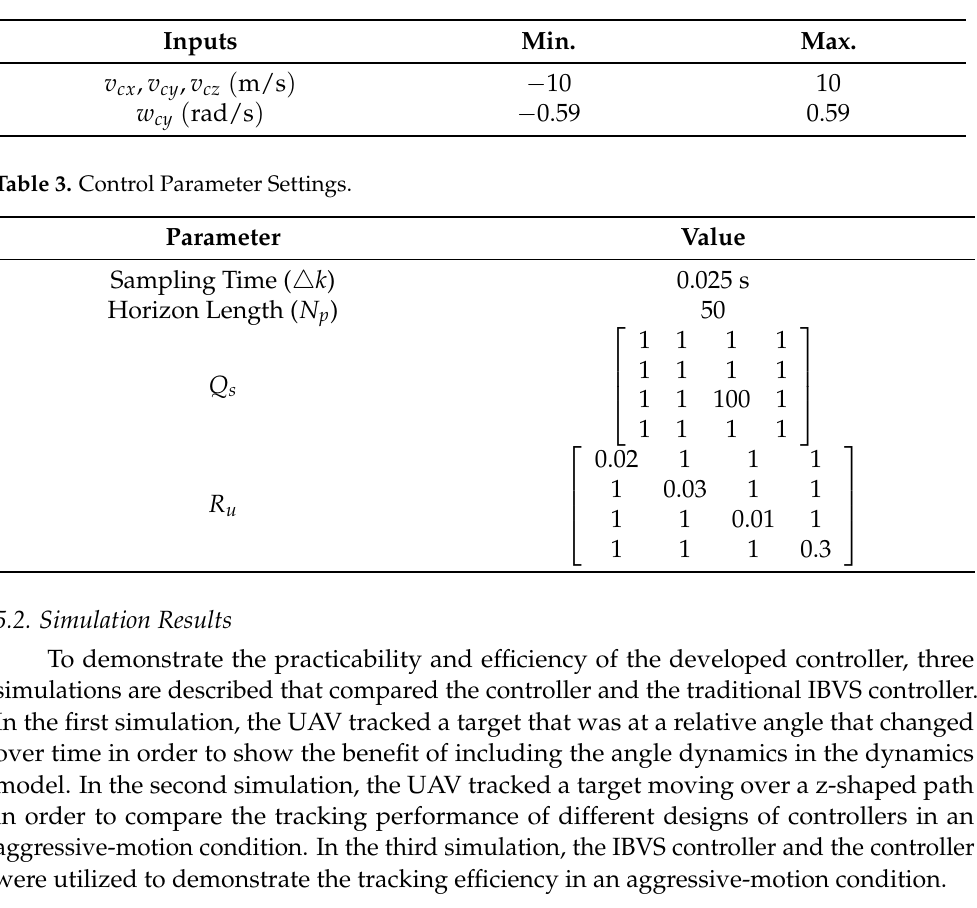
Table 2. Control Constraints.